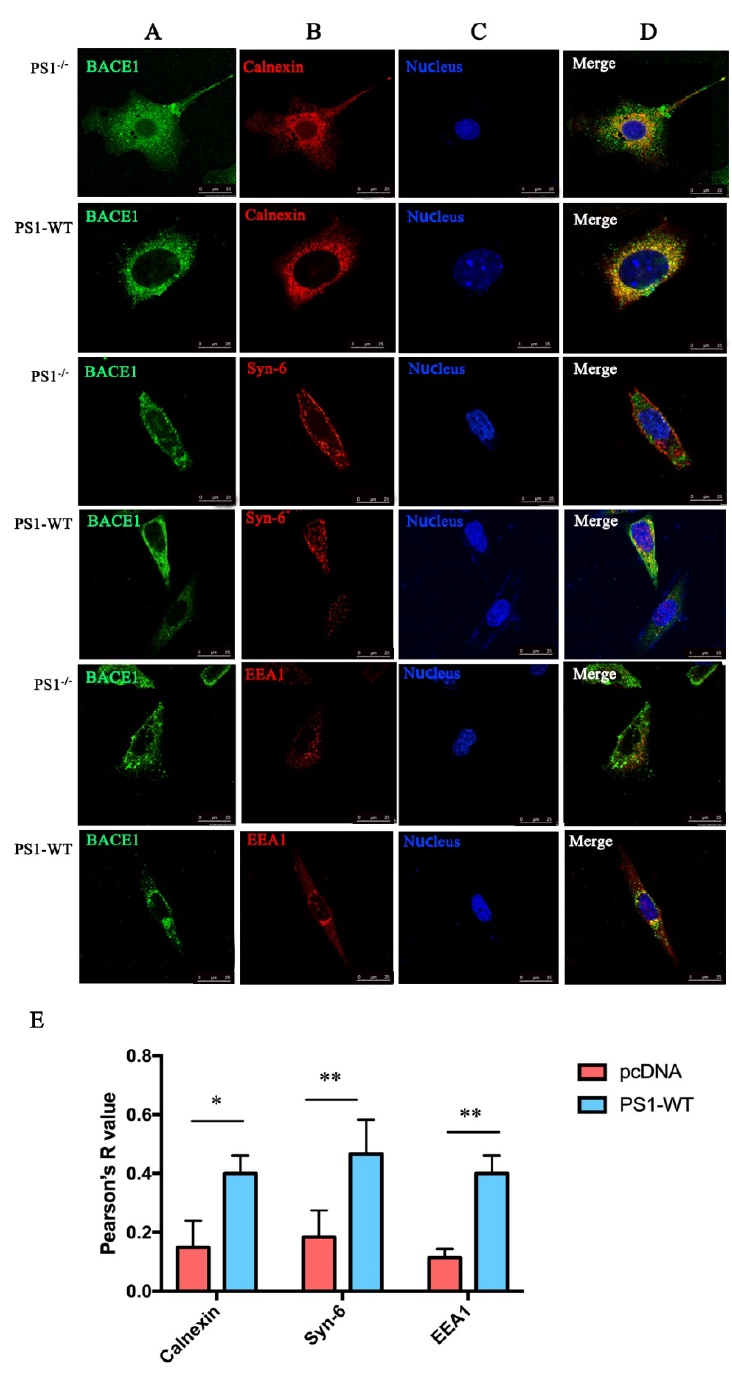
Figure 3. Intracellular distribution of BACE1 with or without PS1 (scale bar = 25 μm). ( A ) BACE1. ( B ) Organelle (calnexin: endoplasmic reticulum; Syn-6: Golgi; EEA1: early endosomes). ( C ) Nucleus (Hoechst33258). ( D ) Merged picture. ( E ) Quantification of the colocalization ratio. Dunnett’s post-hoc test: ** p < 0.01, * p < 0.05, ( n = 3). Similar results were detected in the Golgi and early endosome (Figure 2). Overex- pression o f PS1 increases the colocalization of BACE1 and syntaxin -6 (red), as well as BACE1 and EEA1 (red). The Golgi is responsible for transporting, modifying, and pack- aging proteins synthesized in the endoplasmic reticulum and delivering the proteins to